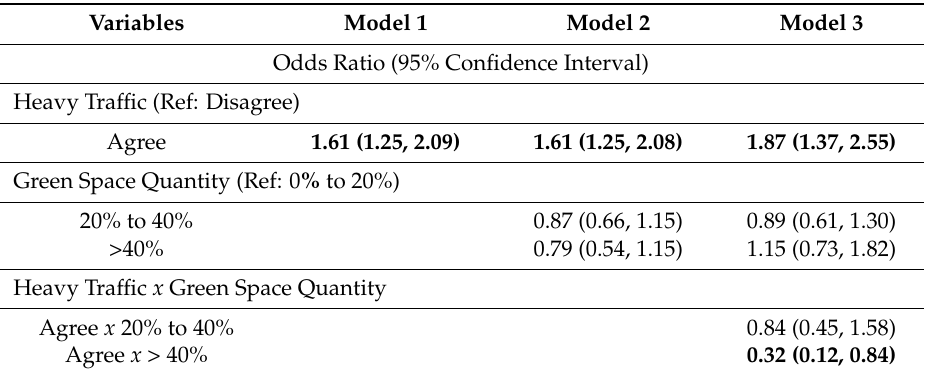
Table 2. Associations and effect measure modification of the association between heavy traffic and child affirmative asthma across strata of green space quantity.